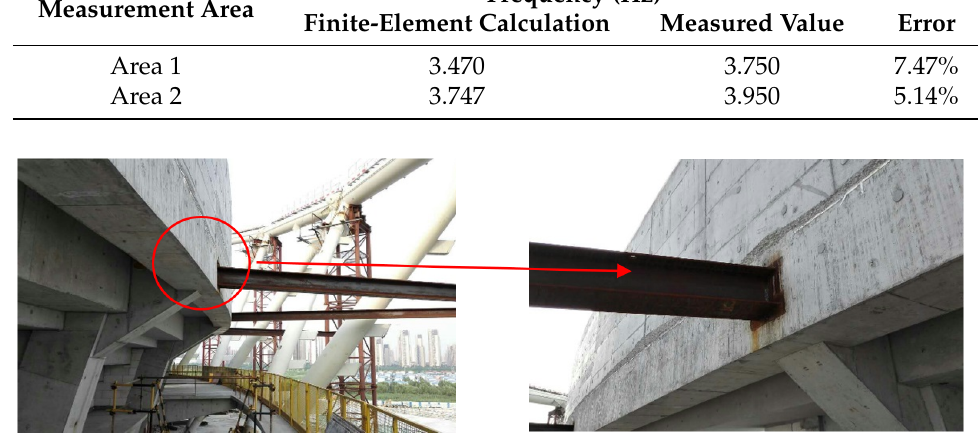
Figure 10. Radial tilt support around stands at the test